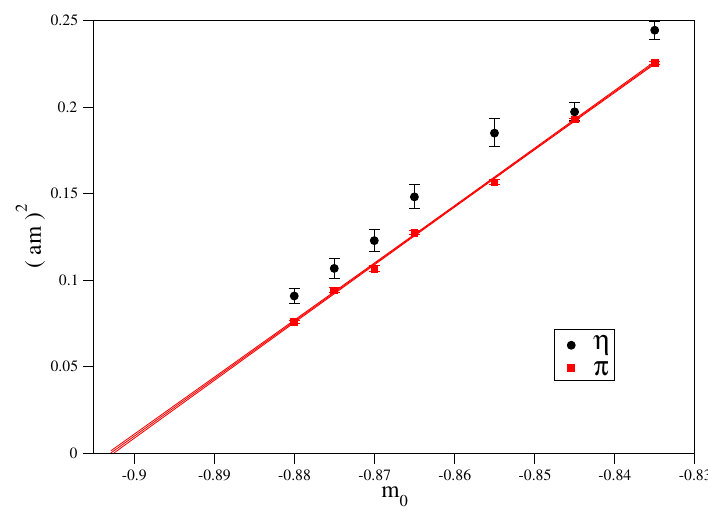
Figure 7 . The squared masses of the (cid:12)ctitious (cid:25) hadron and its comparison to the physical (cid:17) in lattice